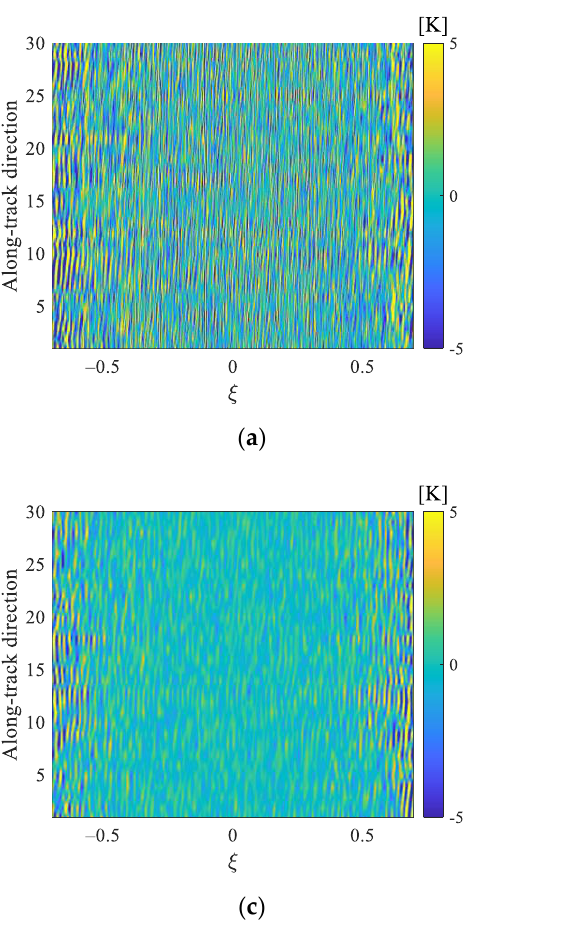
Figure 10. Reconstruction error maps for different regularization methods: ( a ) TV regularization; ( b ) Tikhonov regularization; ( c ) band-limited regularization; ( d ) multi-parameter regularization.